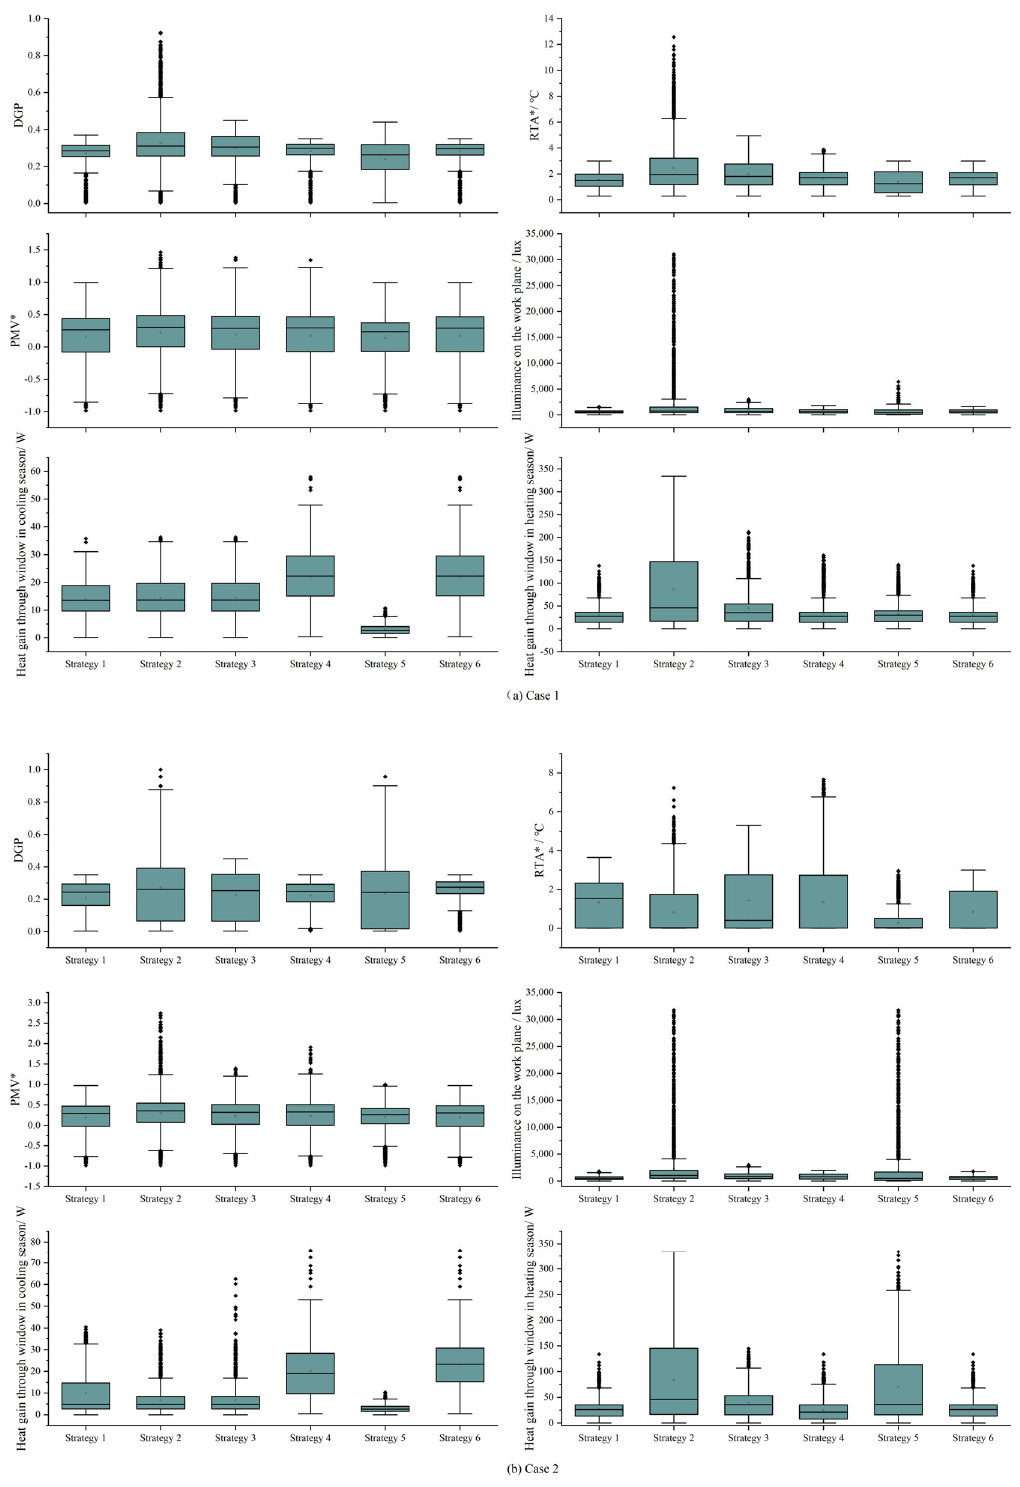
Figure 8. Box chart of six indices in case 1 ( a ) and case 2 ( b ).